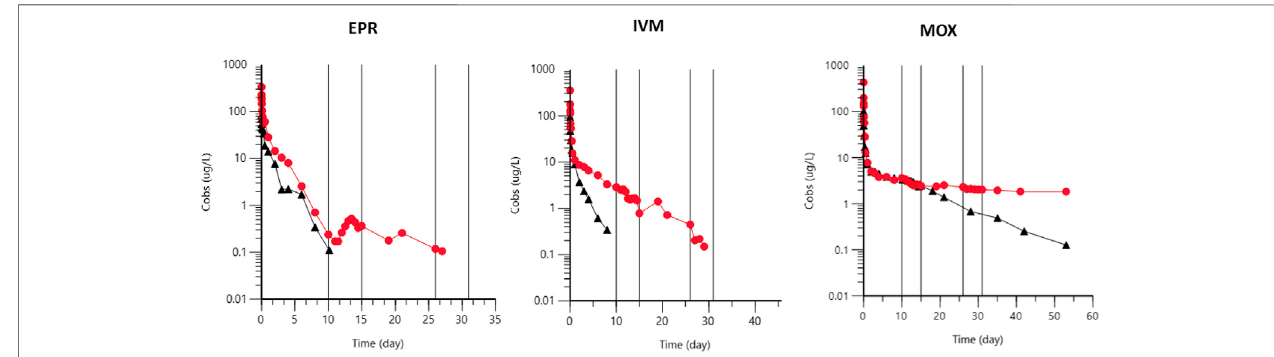
FIGURE 7 | Effect of a 2-day fasting episode followed by a 3-days caloric restriction triggered 10 days (lean dog, black dots) or 10 and 26 days (obese dog, red dots)afteradministrationofEPR,IVM,andMOXonplasmaconcentrationsofeachdruginarepresentativedog(dogB).Verticallinesindicateepisodesoffasting(2days) followed by caloric restriction (3